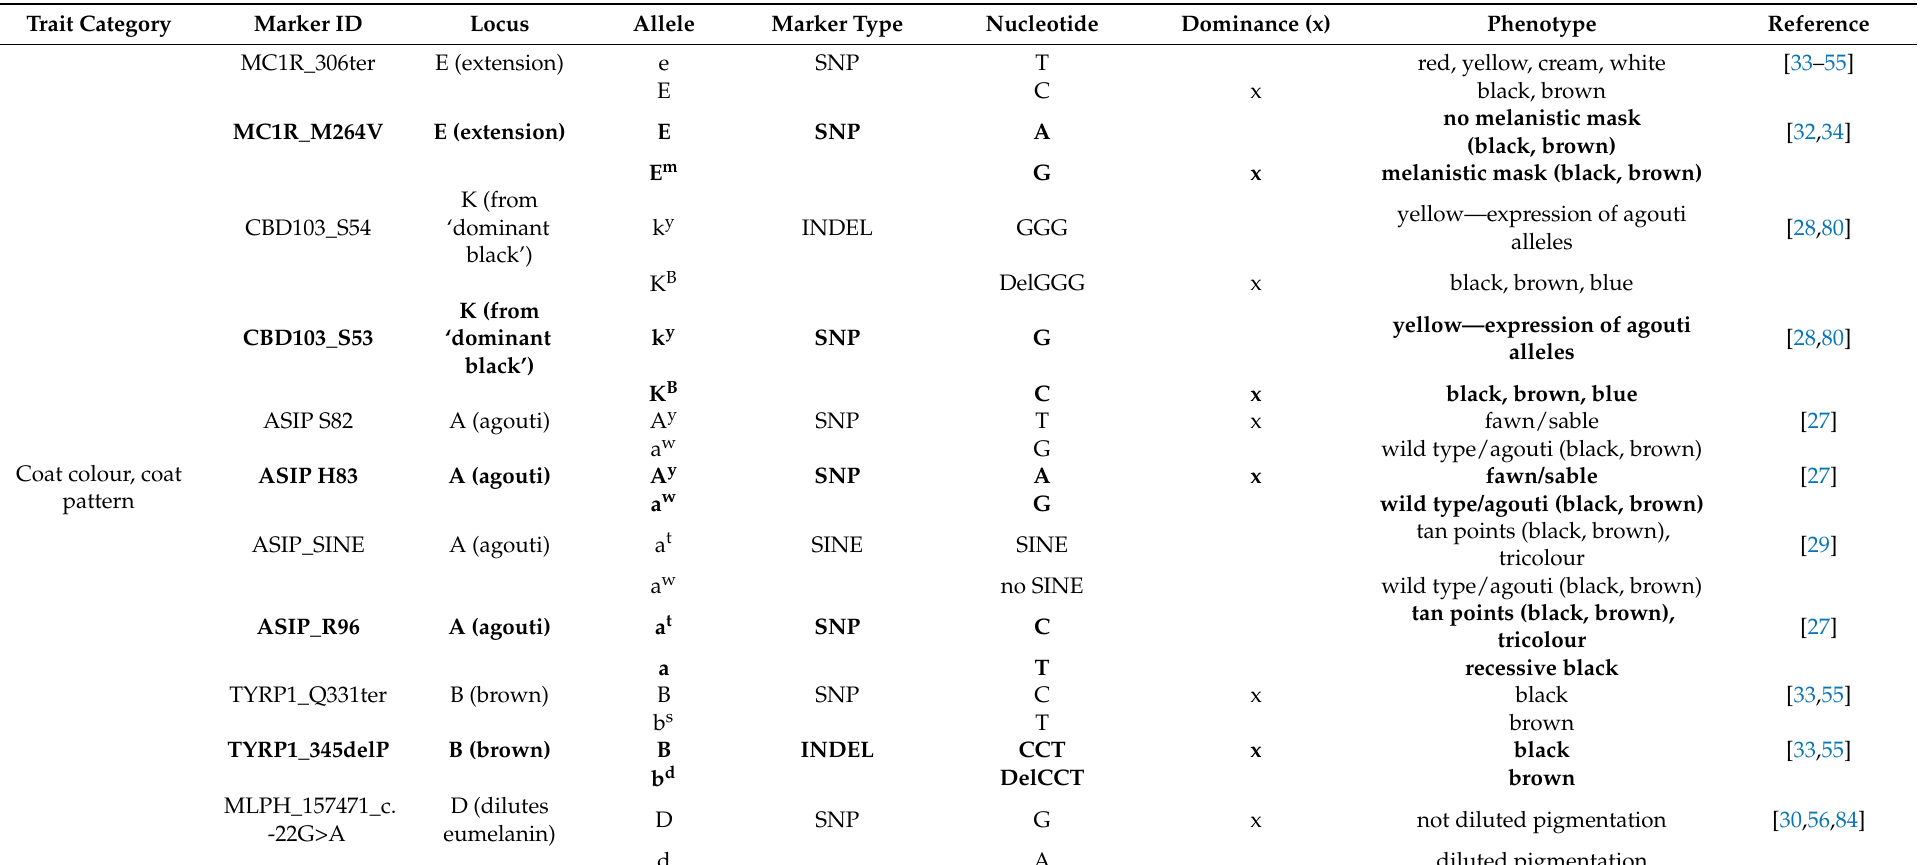
Table 1. Detailed information on the selected 21 phenotype-specific markers allocated to the respective trait category. For the coat colour and coat pattern markers, the commonly used locus (Locus) and allele names (Allele) are listed (see, for example, reviews [38,40]). Upper case letters of an allele refer to dominant inheritance, lower case letters to recessive inheritance. For a detailed description of external visible traits (phenotype), see Sections 3.2.1–3.2.3. Additionally, the phenotypic manifestation is given as well as the corresponding references. Sequence information for the marker types INDEL and SINE are given in Table S2b. n.a. not